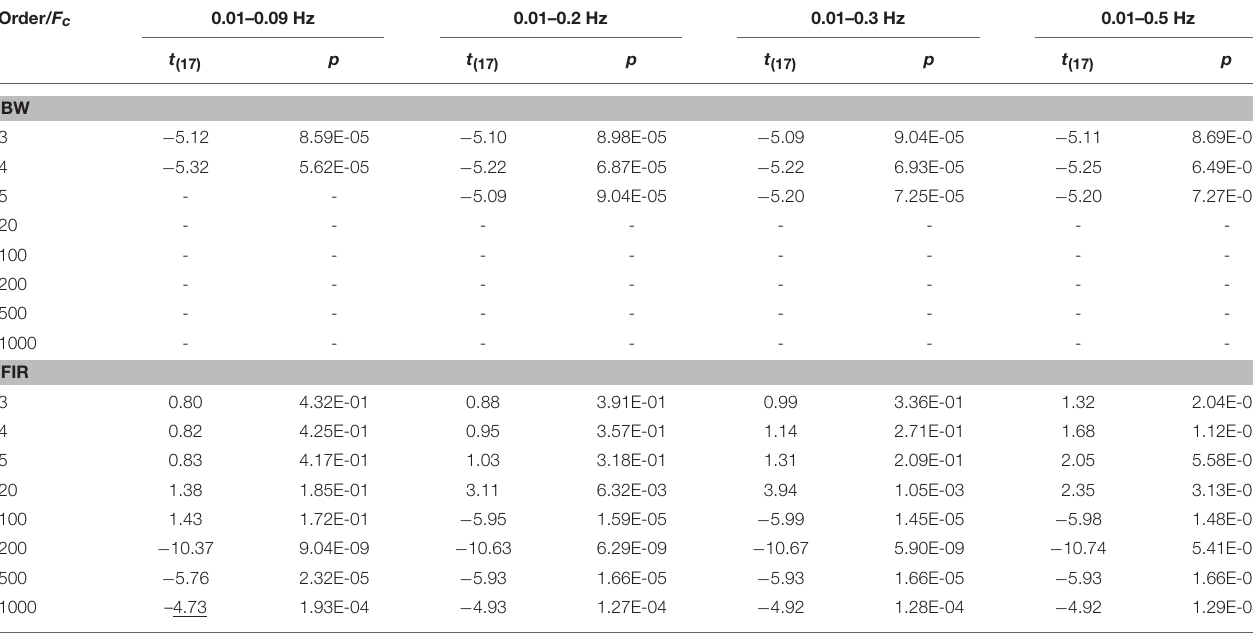
TABLE 6 | One sample t -test results computed on 1 HbO C 2 BP filtered data, with Amplitude 1, comparing the group median β -values to the reference β , in case of precoloring correction.